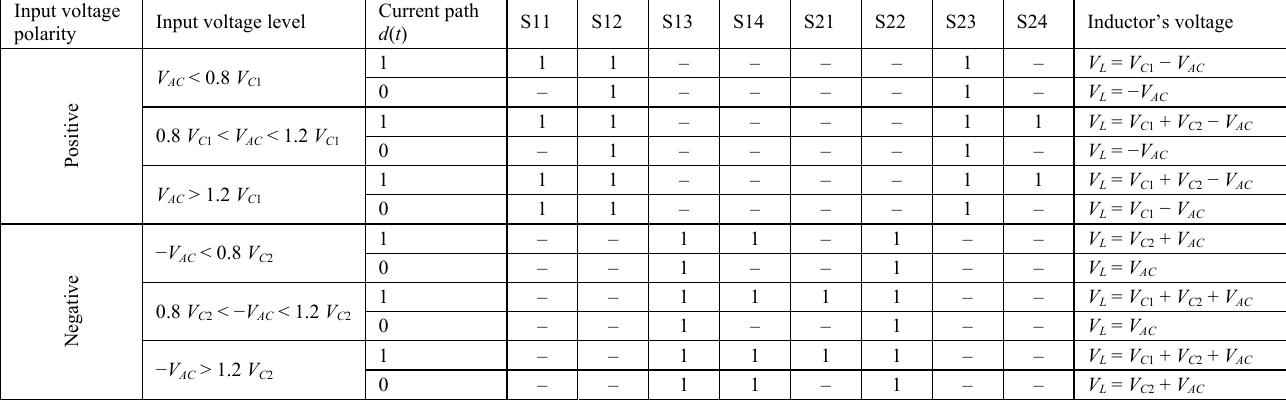
S UMMARY OF S WITCHING S IGNAL C OMBINATION AND C ORRESPONDING I NDUCTOR V OLTAGE